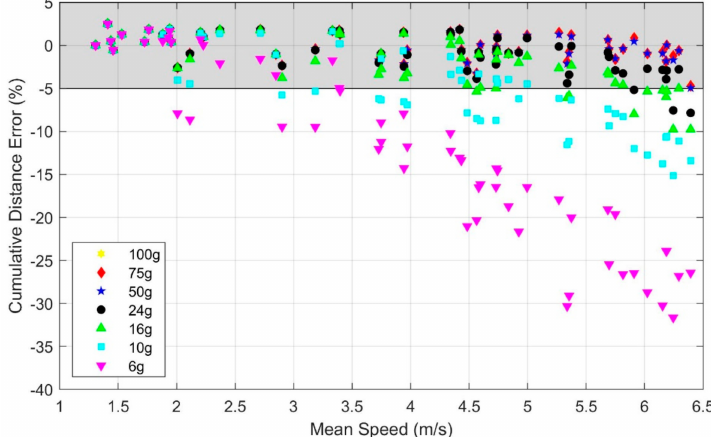
Figure 3. E ff ect of accelerometer range and mean running speed on the cumulative distance error. Note that errors arising from the 100, 75, and 50 g accelerometers are indistinguishable on this scale. The shaded region indicates estimates within ± 5% error.